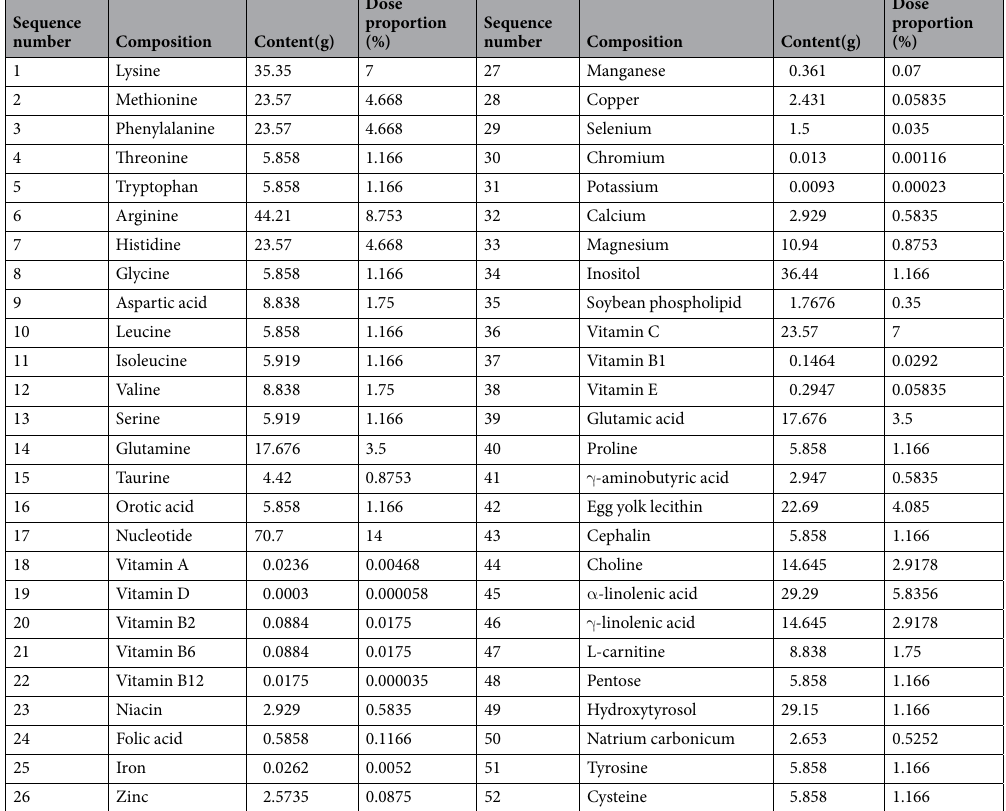
Table 3. Composition, content, and proportion of nutrient mixture. According to the Chinese Nutrition Society in 2013, nutrient mixture was composed of 52 ingredients, including different amino acids, nucleotides, vitamins, trace elements,